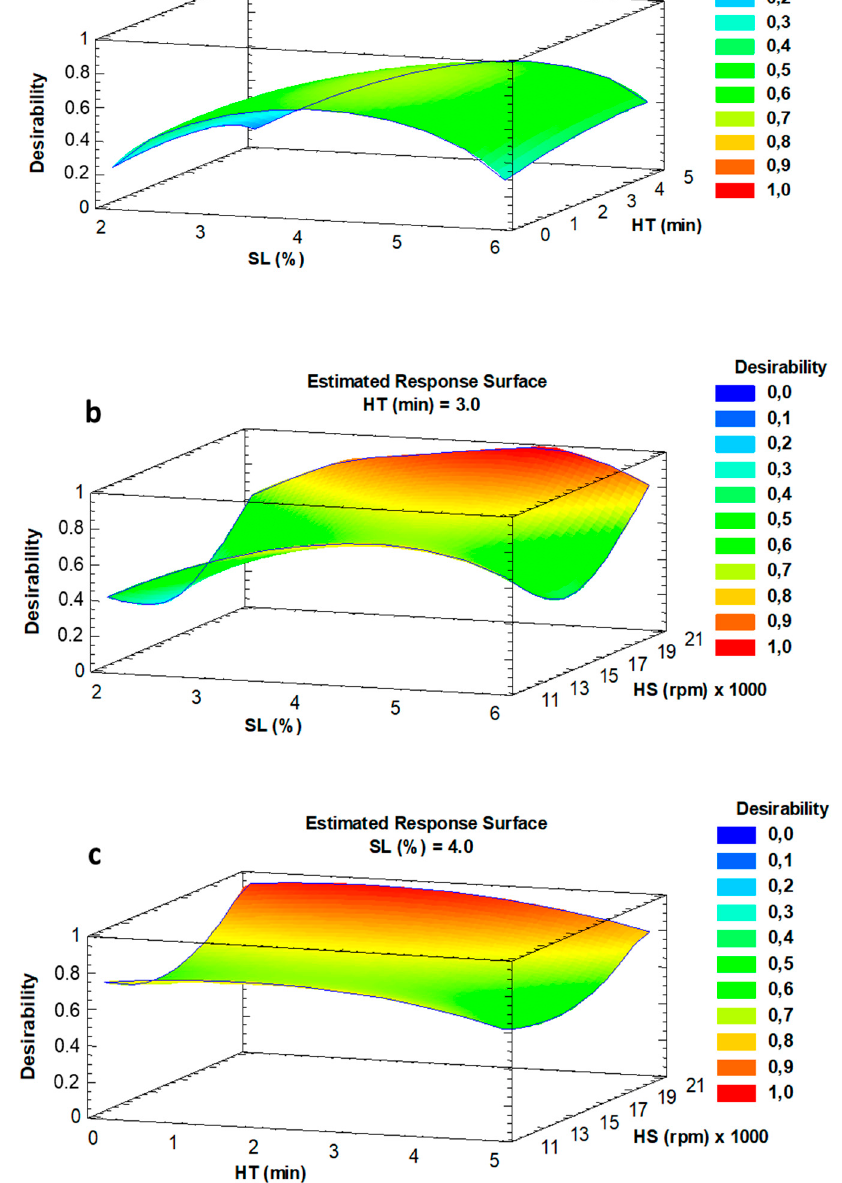
Figure 1. Desirability function for PWO emulsion preparation ( a – c ). SL: soy lecithin;